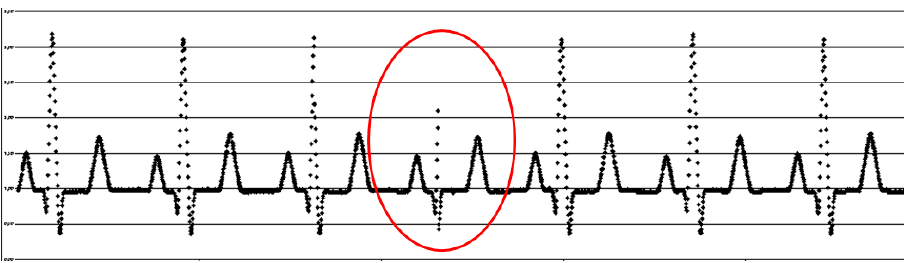
Figure 9. Blackout event in a synthetic ECG signal. The input signal to the system for this figure was created using MATLAB software.